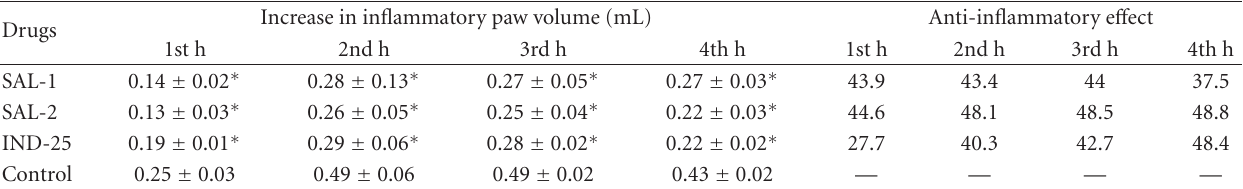
Table 1: E ff ects of salbutamol and indomethacin on carrageenan-induced inflammatory paw edema in rats.